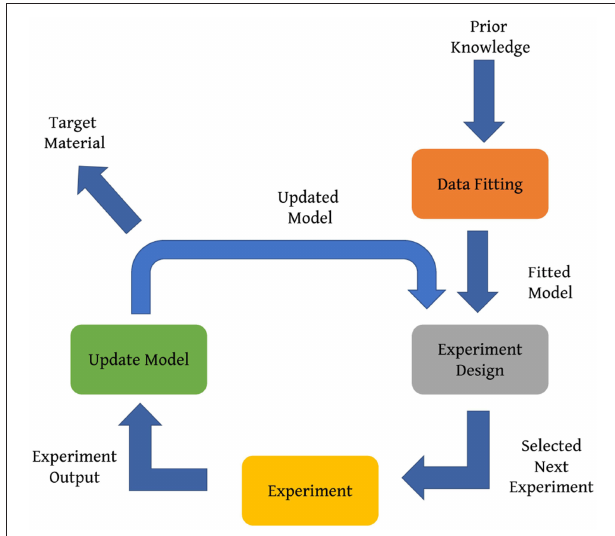
FIGURE 1 | A schematic of the recursive experiment design